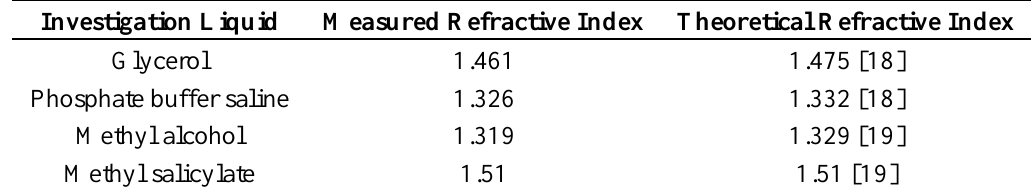
Table 1. Refractive index results of some investigated